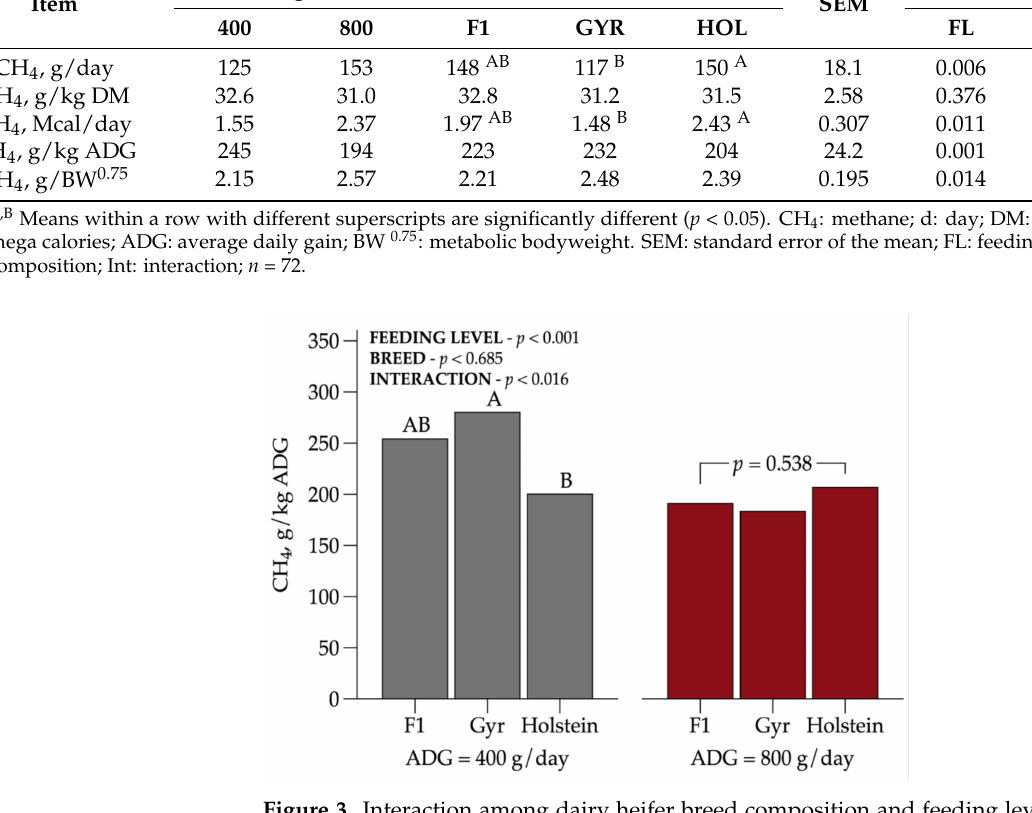
Table 4. Methane (CH 4 ) emission of dairy heifers of three breed compositions (BCs) at two performance levels (PLs). Item